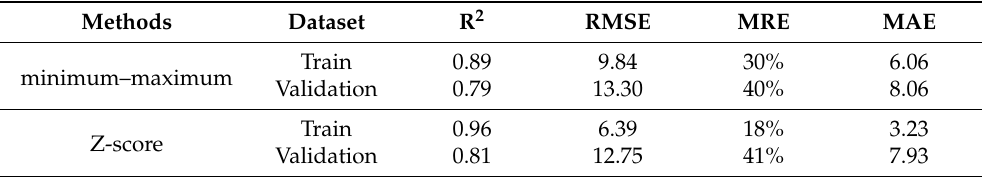
Table 1. Experimental results of two normalization